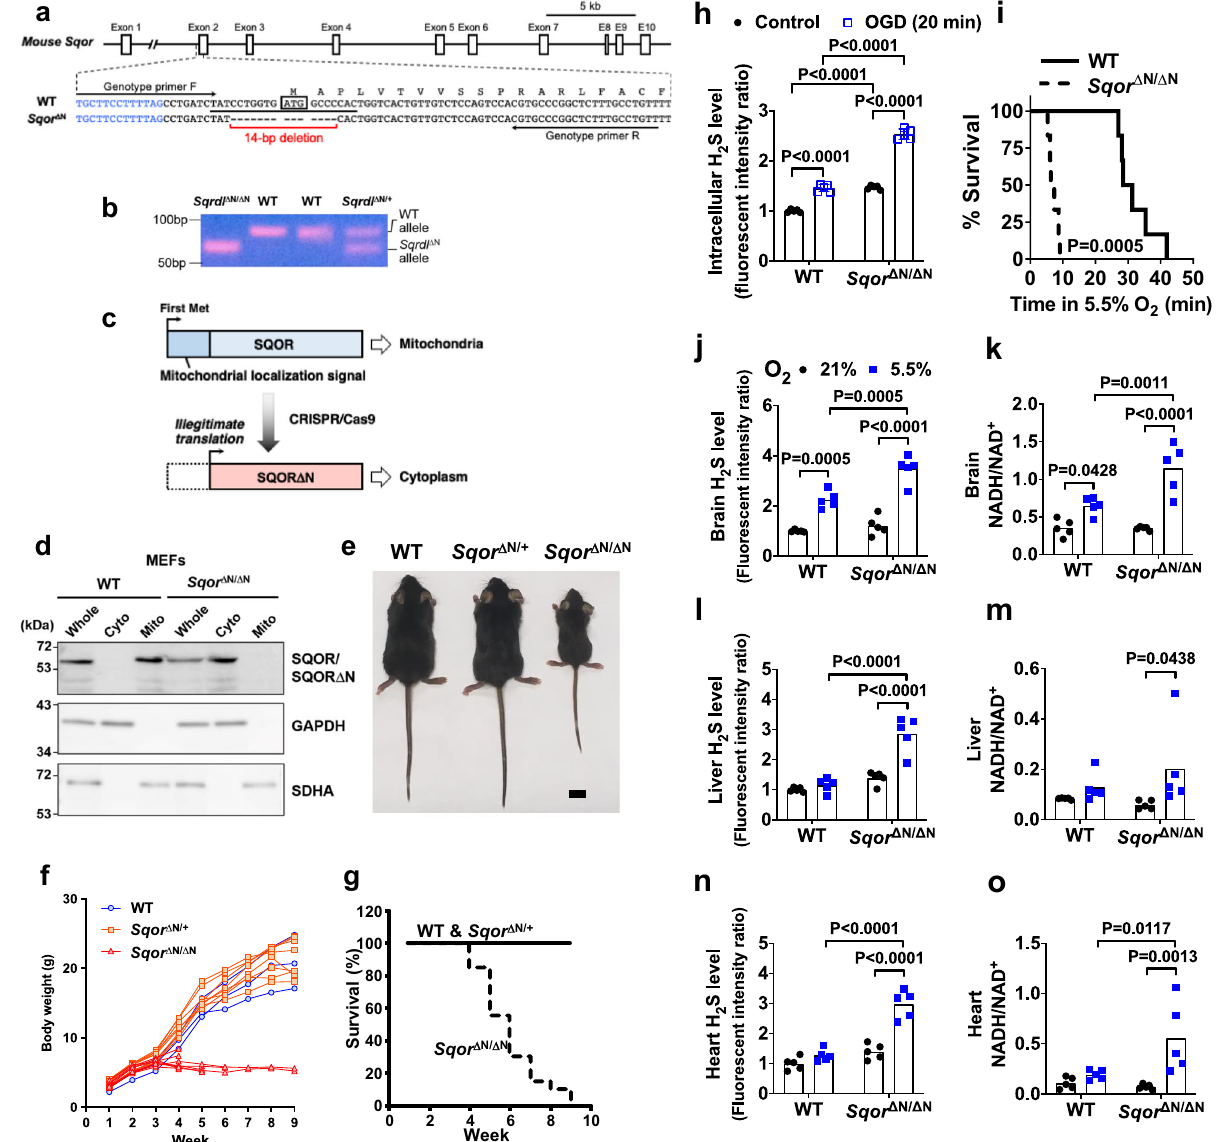
Fig. 3 Generation of SQOR mutant mice and their increased sensitivity to hypoxia. a Schematic illustration of the murine Sqor gene structure and sequences of WT and mutant alleles spanning the translation initiation codon. Blue letters and black letters indicate the fi rst intron and the second exon, respectively. ATG enclosed by a box indicates the fi rst methionine codon. A target sequence of gRNA is underlined. Target sequences for genotyping primers are indicated by arrows. b PCR detection of a deletion in the Sqor gene. Genomic DNAs from WT, Sqor Δ N/ + , and Sqor Δ N/ Δ N mice were ampli fi ed with a primer set shown in a . Representative PCR gel images of 3 independent biological replicates of each are shown. c Schematic presentation of SQOR proteins expressed by WT and Sqor Δ N alleles. d Immunoblot analysis of whole-cell lysates (Whole) and cytosolic (Cyto) and mitochondrial (Mito) fractions of MEFs established from WT and Sqor Δ N/ Δ N embryos. Representative immunoblots of 3 independent biological replicates for each are shown. Protein samples were prepared for detection of SQOR, GAPDH (cytosolic marker), and SDHA (mitochondrial marker). e Macroscopic appearance of 5- week-old WT, Sqor Δ N/ + , and Sqor Δ N/ Δ N littermate male mice. Scale bar, 1 cm. Representative images of more than three of each genotype are shown. f Body weight gain and g survival rate of Sqor Δ N/ Δ N mice ( n = 20) compared with Sqor Δ N/ + mice and WT mice ( n = 70). h Relative intracellular H 2 S levels of primary cortical neurons obtained and cultured from Sqor Δ N/ Δ N mice and their wild-type littermates embryos subjected to oxygen-glucose deprivation (OGD). i Survival curve of Sqor Δ N/ Δ N mice and their wild-type littermates breathing 5.5% oxygen. Relative levels of sul fi de in j , l , n and the ratio of NADH/ NAD + in k , m , o in the brain, liver, or heart, respectively, of Sqor Δ N/ Δ N mice and their wild-type littermates breathing 5.5% oxygen ( N = 5 each). Data are presented as mean and individual values. Two-way ANOVA followed by Tukey ’ s correction for post-hoc comparisons were performed for h and j – l , n , and o . Survival rates were estimated using the Kaplan – Meier method and a log-rank test was used to compare the survival curves between groups in i . Kruskal – Wallis test followed by Dunn ’ s multiple comparisons was performed for m